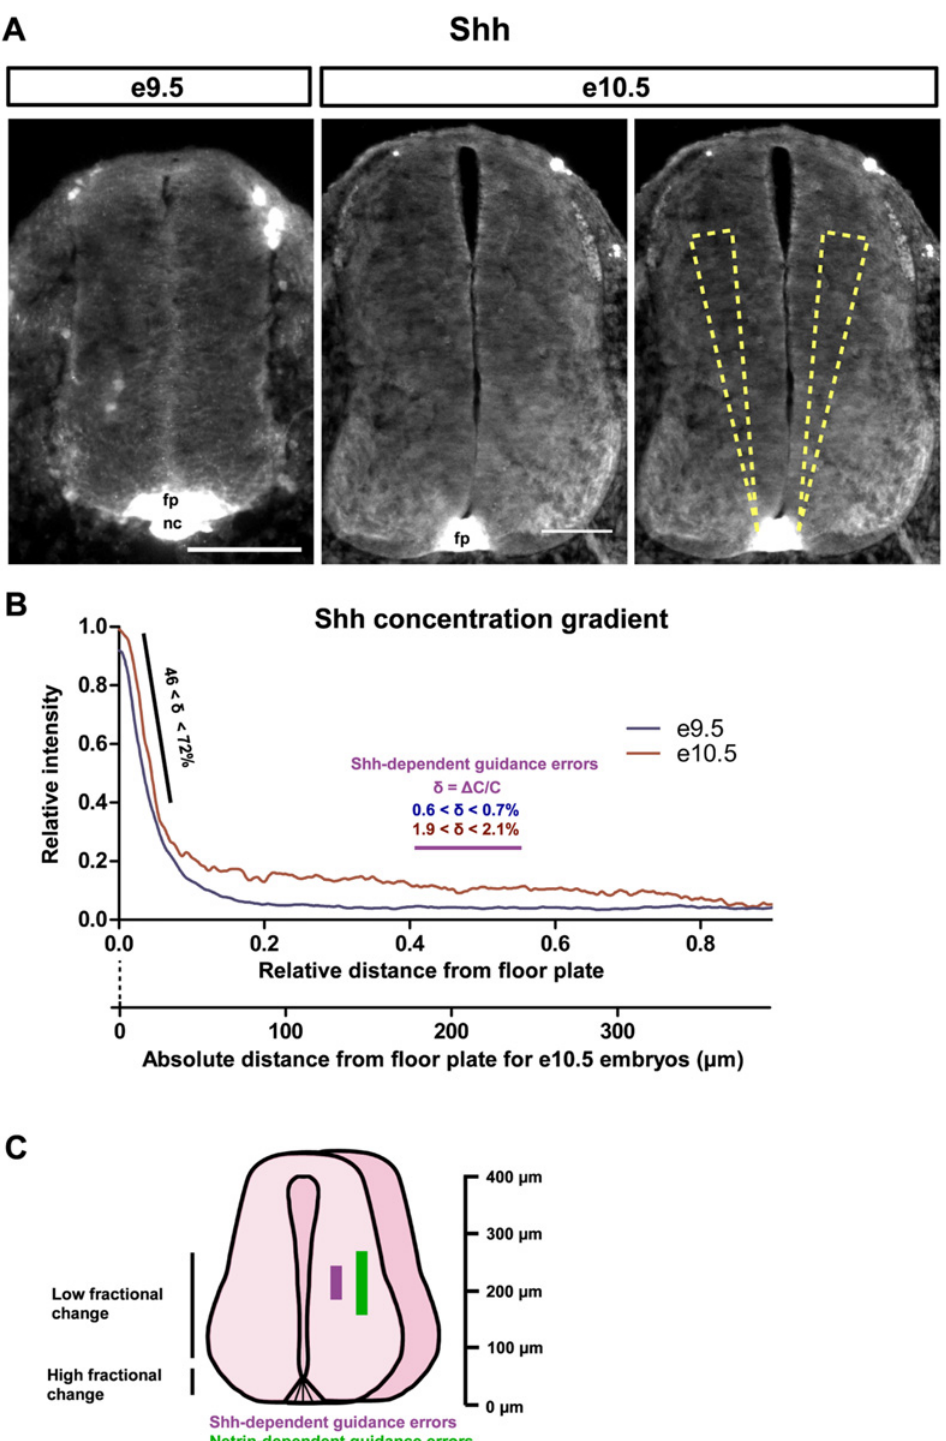
Fig 1. Axon misguidance phenotypes in vivo occur where the Shh gradient is shallow. (A) Mouse e9.5 (left) and e10.5 (middle and right) spinal cord cross-sections immunostained for Shh. We measured fluorescence intensity profiles at multiple angles along the cross-section of the spinal cord; angle range indicated by wedges (right). (B) Shh concentration was highest at the floor plate and decreased rapidly in the first ~50 μ m (relative distance of 0 – 0.1) from the floor plate. Beyond this steep decline in intensity, there was a residual shallow gradient extending > 300 μ m, up to a relative distance of 0.8 from the floor plate to the roof plate. 29 sections from two e9.5 embryos and 15 sections from two e10.5 embryos were analyzed. The steepness of the gradient, δ ,